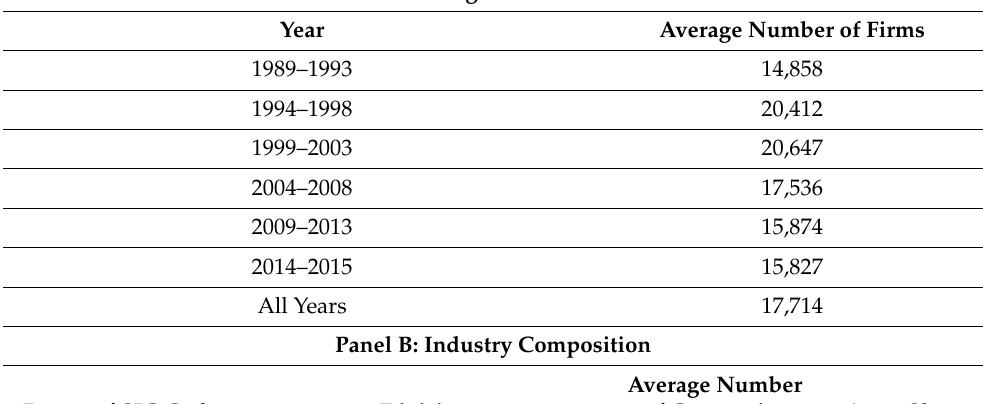
Table 1. Sample Composition. Panel A: Average Number of